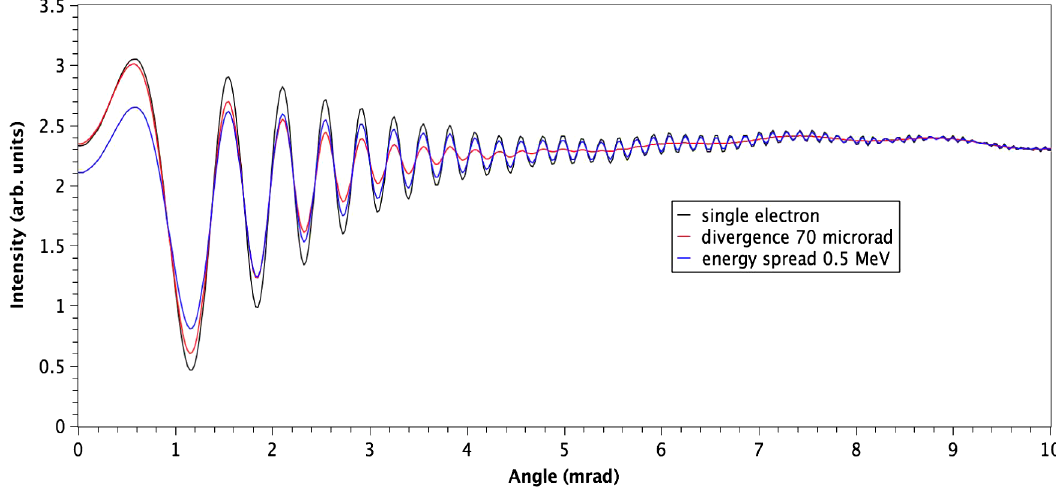
FIG. 10. OSR interferences from magnets (2,3) and beam energy E ¼ 100 MeV, showing the fringe visibility for a single electron and a beam with 0.5 energy spread; as well as a beam with divergence 70 μ rad (red).